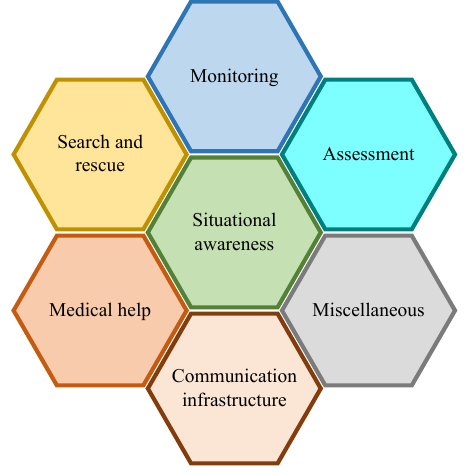
Figure 1. Classification of applications of UAVs-enabled IoT platform in disaster